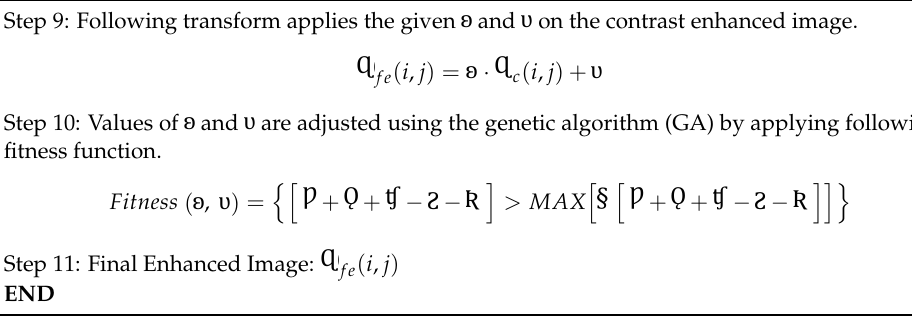
Table 1. Numerical results of contrast enhancement.